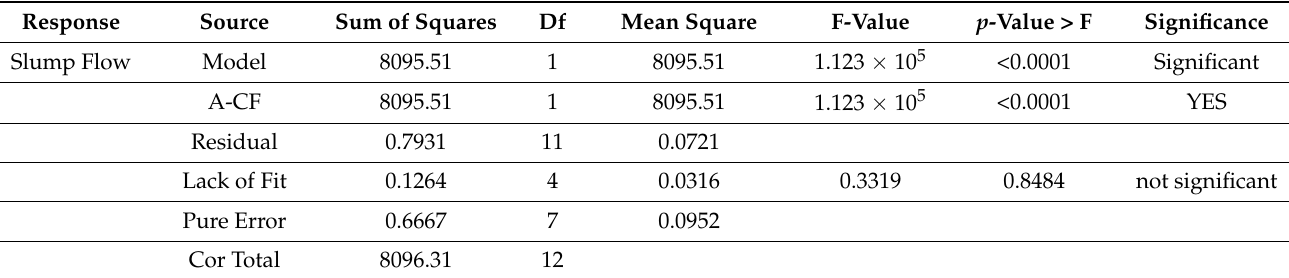
Table 4. ANOVA Results for the Variable Response Slump